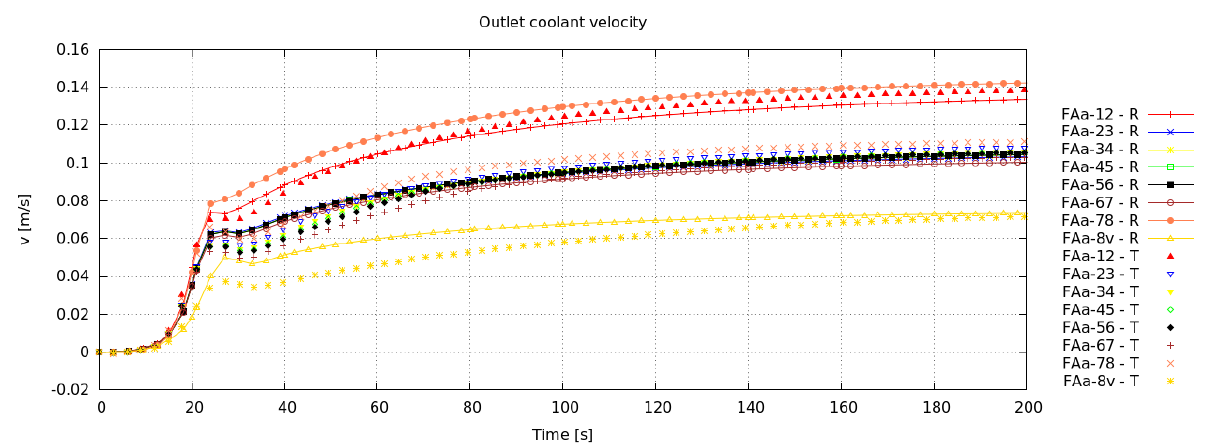
Figure 5. Outlet coolant velocity during step increase of reactivity accident by 0.7 β